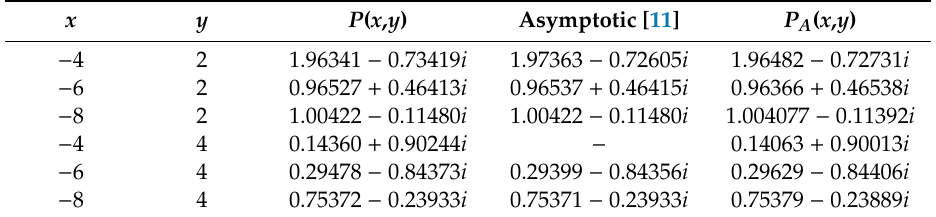
Table 3. Values of P ( x , y ) obtained for large negative values of x when y = 2 and 4 compared to the asymptotic values [15] and the present work.